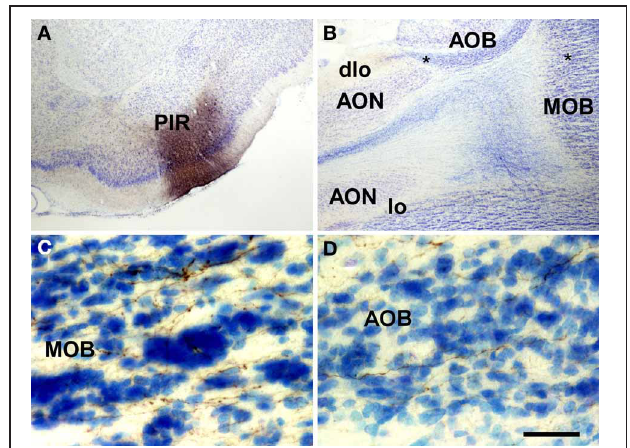
FIGURE 5 | Coronal (A) and sagittal (B–D) sections of the telencephalic hemisphere showing the resulting labeling (B–D) after a biotinylated dextran-amine injection in the rat piriform cortex (A). Asterisks in B indicate the approximate location of panels C and D . Abbreviations: AOB, accessory olfactory bulb; AON, anterior olfactory nucleus; dlo, dorsal lateral olfactory tract; lo, lateral olfactory tract; MOB, main olfactory bulb; PIR, piriform cortex. Scale bar for A : 800 μ m, B : 400 μ m, C,D : 40 μ